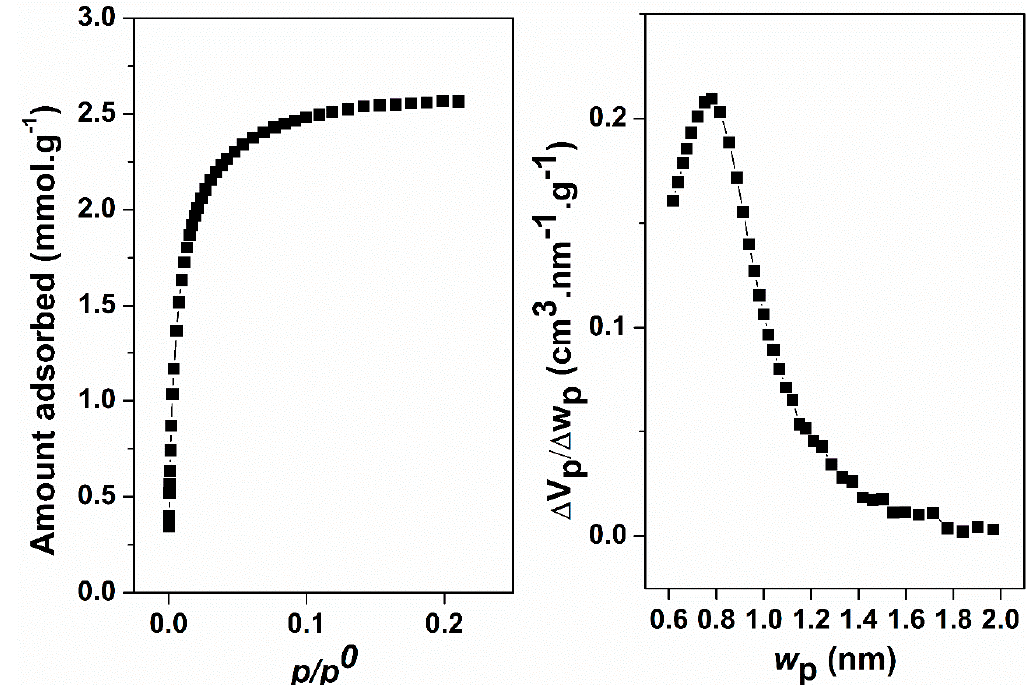
Figure 7. CO 2 adsorption isotherm (left) for the zeolitic sample, ZSM-5-diatomite, and the corresponding micropore-size distribution (right), resulting approximately a modal micropore size of 0.8 nm.